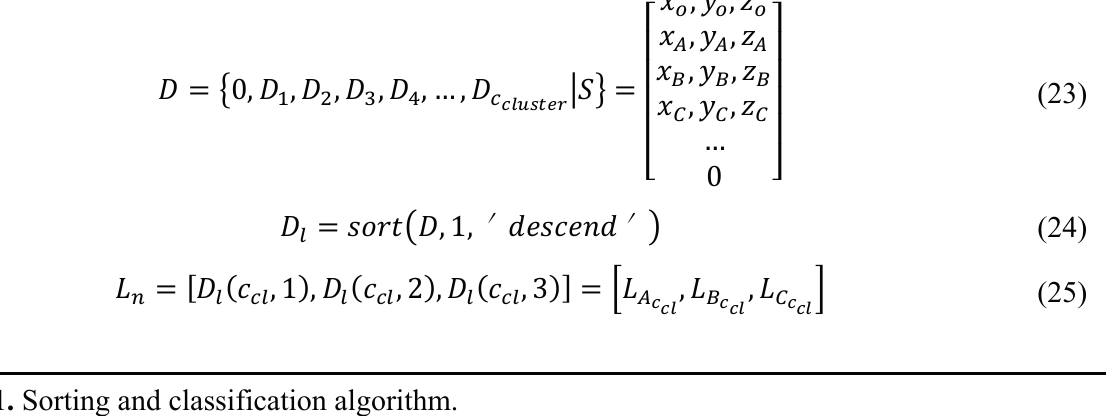
Algorithm 1. Sorting and classification